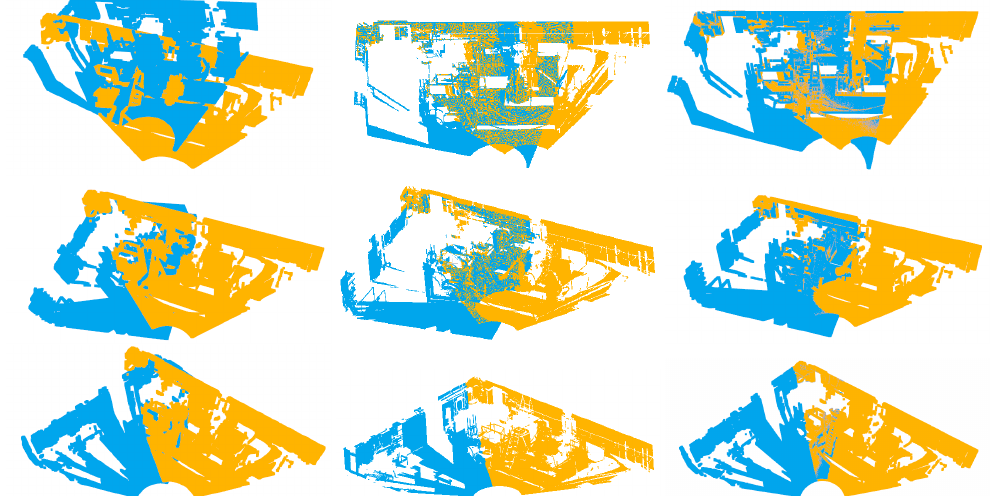
Figure 8. Registration results of SCS-Net for a realistic application. ( Left ): before registration, ( middle ): ground truth, and ( right ): after registration.